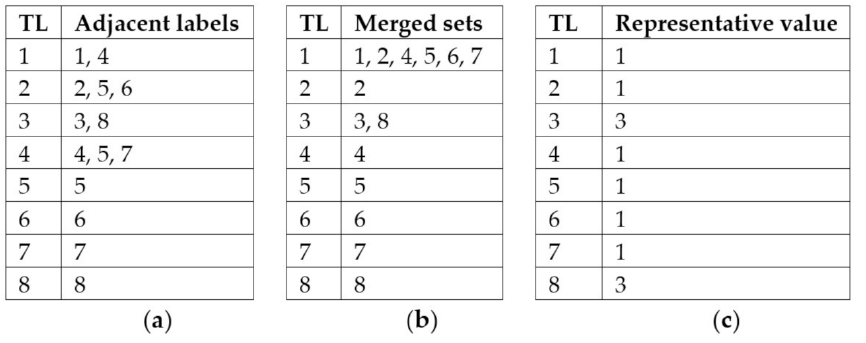
Figure 4. Example of the resolving step: ( a ) synthetic resultant LL, ( b ) LL after sets merged; ( c ) the temporary values and their representative